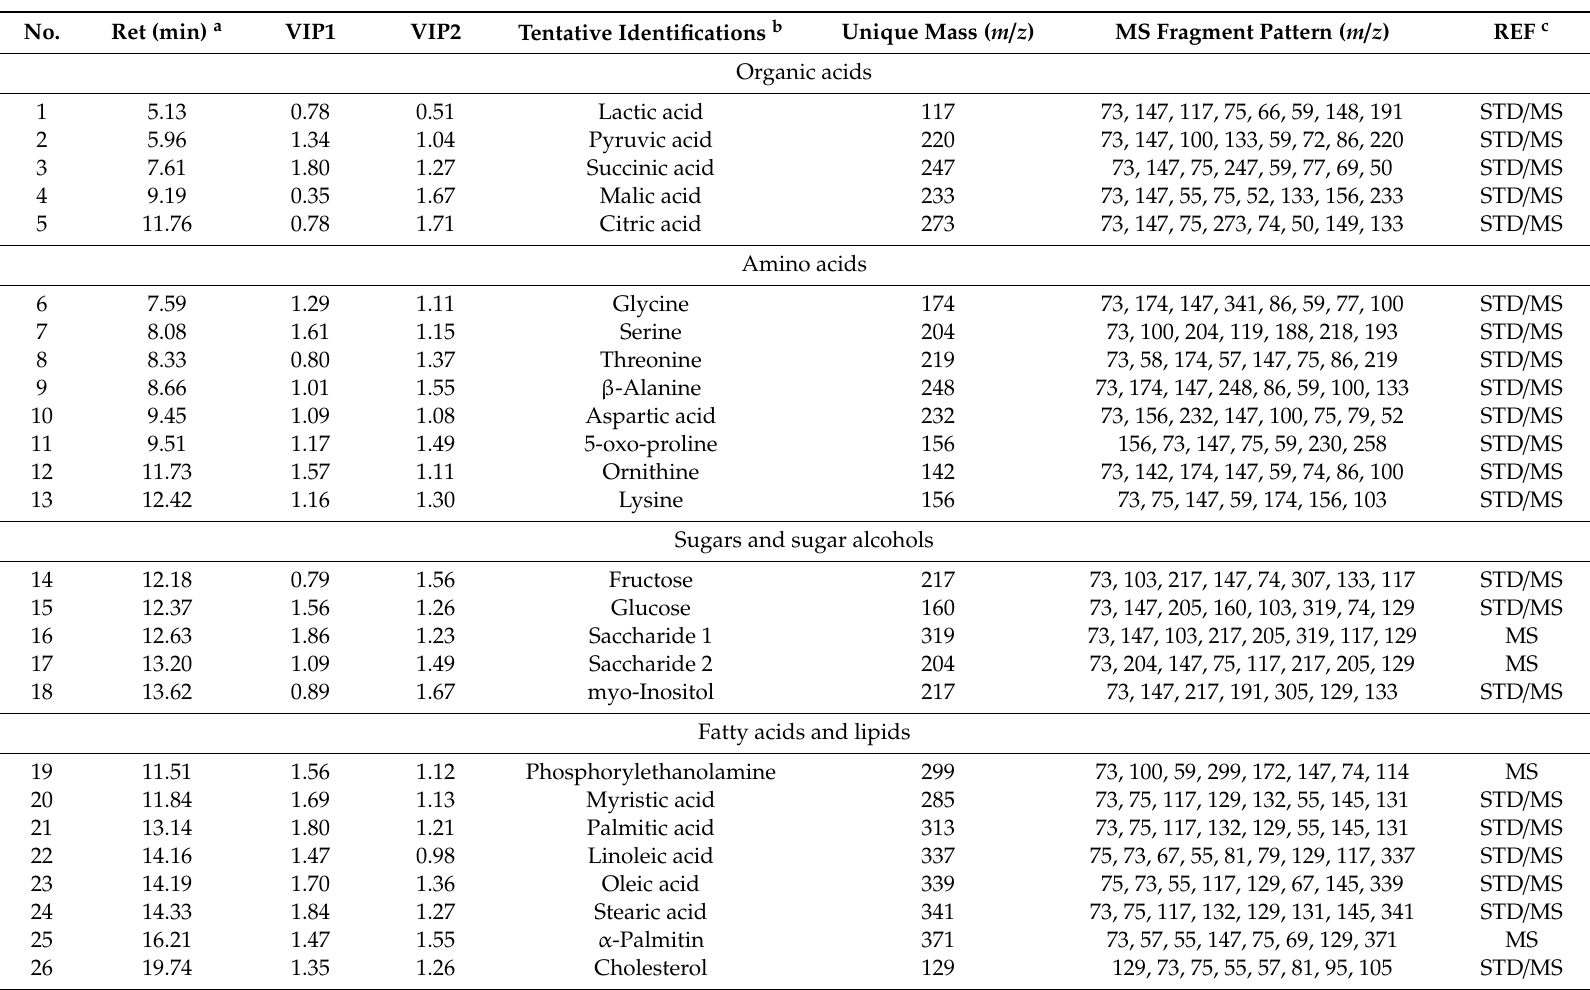
Table 1. List of the significantly di ff erent metabolites selected using the PLS-DA model based on the GC-TOF-MS dataset for 4 di ff erent leukemia cells and normal HSC.